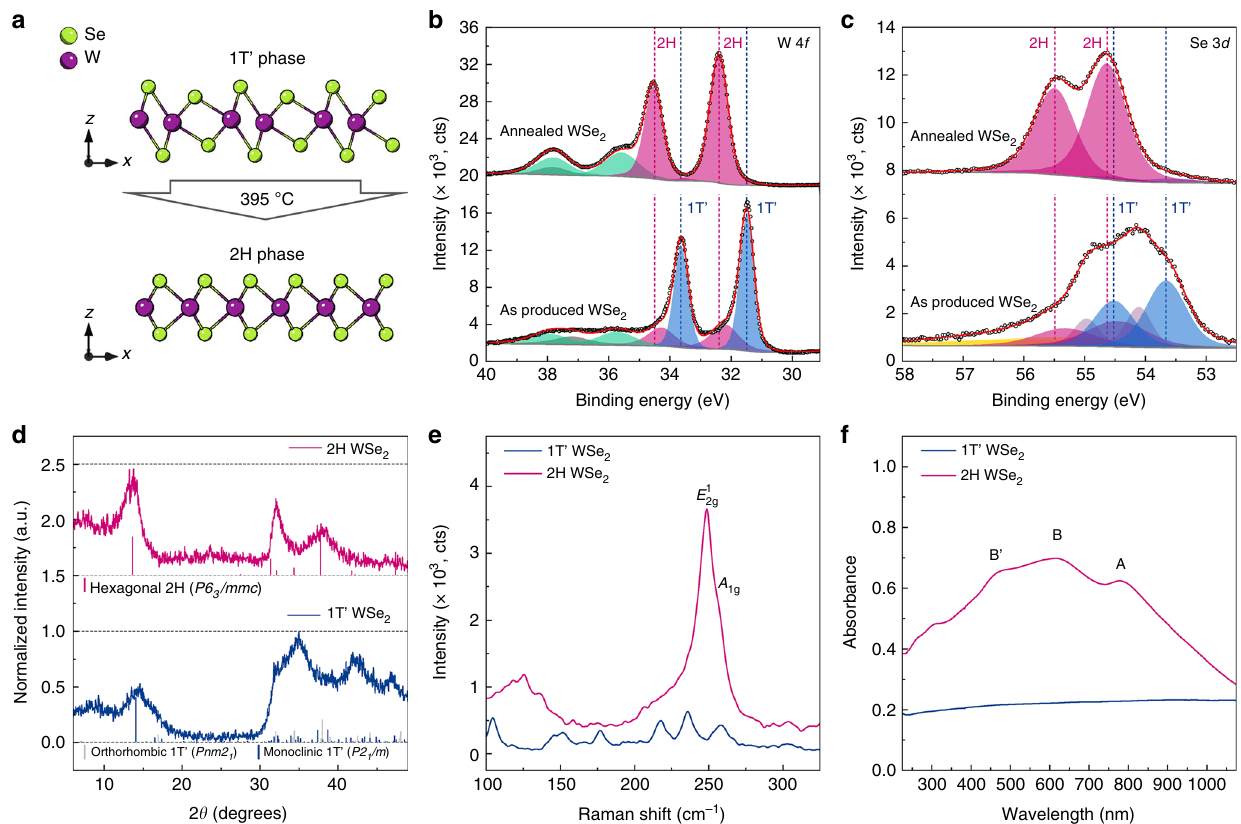
Fig. 2 1T ’ to 2H phase transformation. a Schematic representation of the 1T ’ to 2H structural phase transition occurring upon thermal annealing. b , c X-ray photoemission spectra (XPS) of the W 4 f and the Se 3 d core-level electrons before (bottom row) and after (upper row) phase conversion, respectively. In XPS spectra, doublets corresponding to the 1T ’ phase of WSe 2 are given in blue, 2H phase of WSe 2 in pink, WO 3 in green, 5 p 3/2 component of WSe 2 in grey, yellow and violet doublets in the Se 3 d spectrum are assigned to the coordinated surface selenium. d X-ray diffraction patterns, e Raman spectra, and f Ultraviolet – visible absorption spectra of the as-produced and the annealed (400 °C) WSe 2 nano fl owers. Raman spectra are presented in the same scale but are offset for